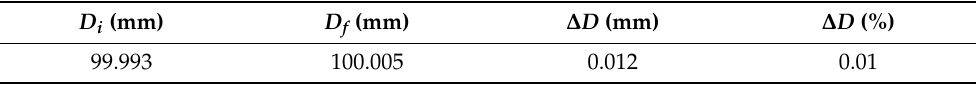
Table 6. Dimensional variation